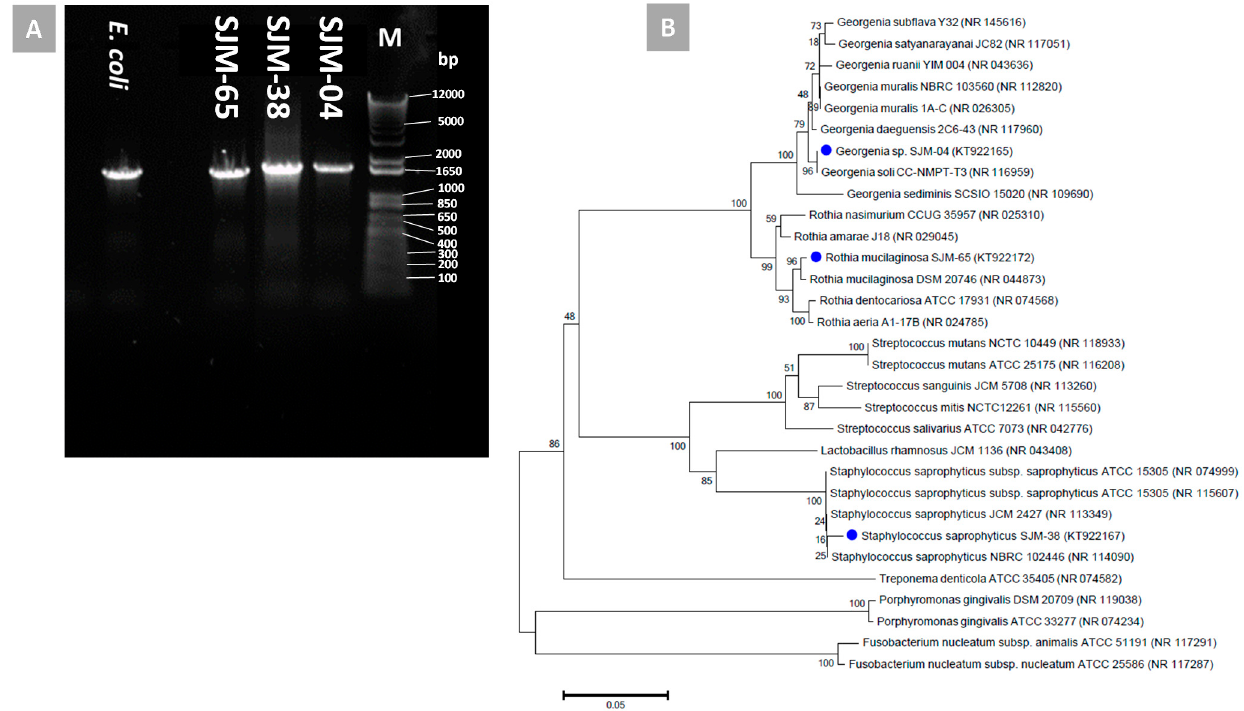
Figure 2. ( A ) shows an agarose gel electrophoresis result for purified 16S rDNA amplicons obtained after PCR amplification using genomic DNAs extracted from biofilm forming oral isolates as templates. ( B ) shows an unrooted neighbor-joined phylogenetic tree of closely related phylogenetic species based on 16S rRNA gene sequences of isolates SJM-04, SJM-38, and SJM-38 (marked with blue symbols). Sequences were aligned using the Clustal W sequence alignment tool in MEGA 7.0 software. The GenBank accession numbers of isolates and closely related species are presented in parenthesis. Bootstrap percentage values as obtained from 1000 replications of the data set are given at tree nodes. The scale bar represents the mean number of nucleotide substitutions per site.